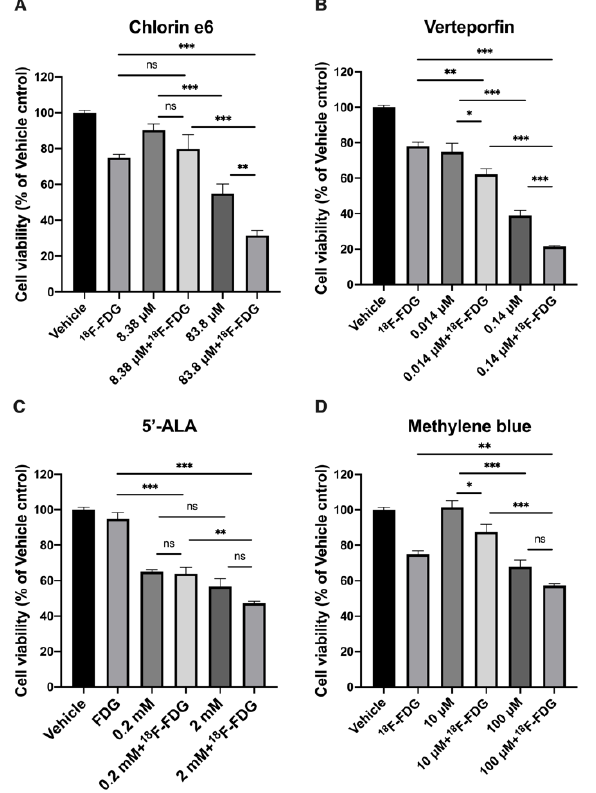
Figure 1. In vitro effect of CR-PDT with 18 F-FDG. Cell viability assay comparing ( A ) Chlorin e6, ( B ) Verteporfin, ( C ) 5′ -ALA and ( D ) methylene blue with and without treatment with 18 F-FDG on ES2-luc cells. In each group, 3.7 MBq of 18 F-FDG was used. Values are means ± SD (Each experiment was performed in triplicates and replicated 3X). * p < 0.05, ** p < 0.01, *** p < 0.001 and n.s., nonsignificant by Student’s t -test.